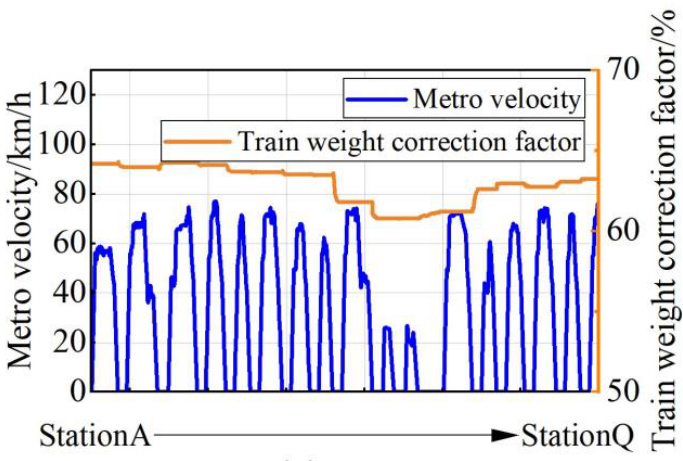
Figure 7. Train operation curves.